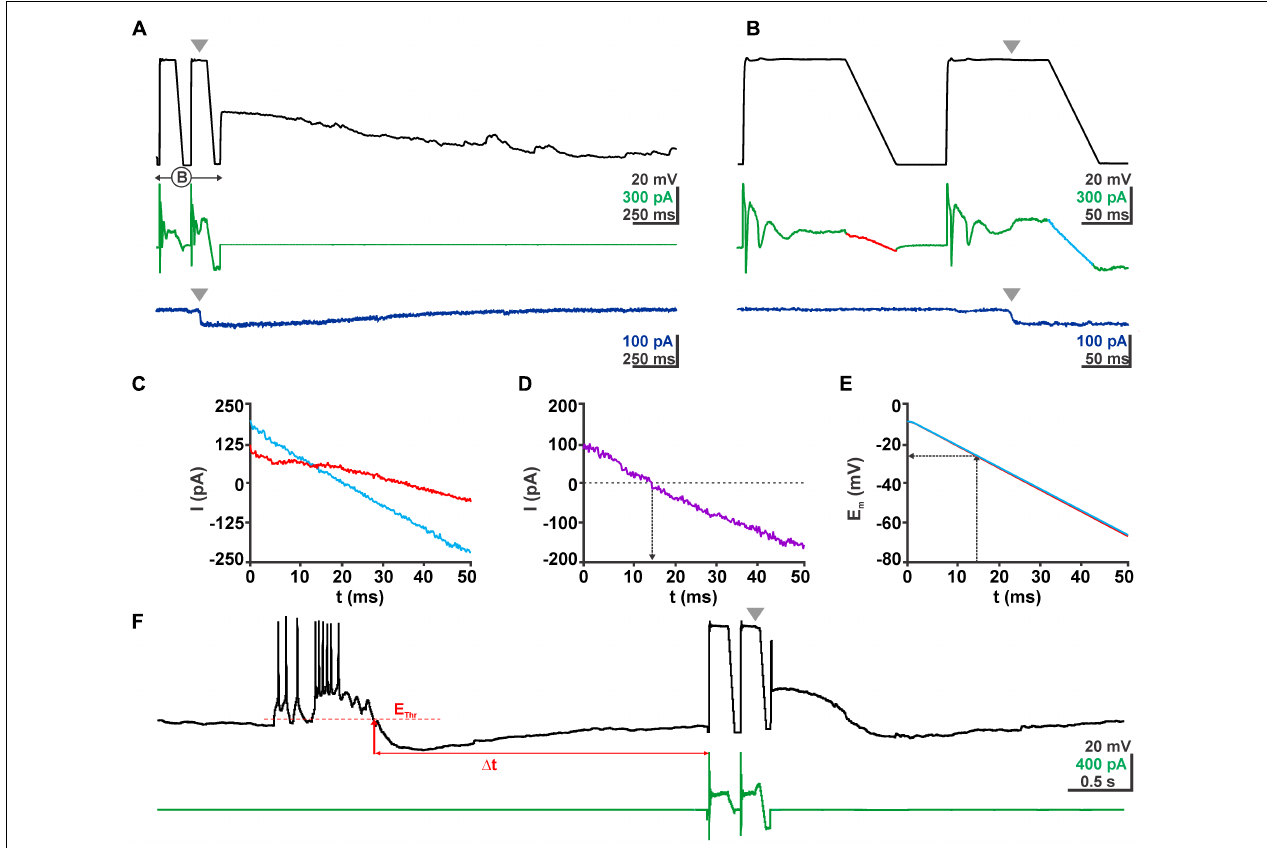
FIGURE 3 | Determination of E GABA using a voltage ramp protocol. (A) Voltage (black trace) and current (green trace) traces of a typical clamp protocol used to determine E GABA . Voltage ramps between –3 and –63 mV were given from a 100 ms long depolarizing phase to inactivate fast Na + currents. The second voltage ramp was delivered during the quasi-stationary phase of GABAergic response evoked by a short application of 100 µ M GABA pulse (gray arrowhead). The dark blue trace in the bottom depicts the current response of the same cell without a voltage ramp protocol to illustrate the stationarity of the GABAergic current during the voltage ramp. (B) The ramp interval as shown in (A) at a higher temporal resolution. (C) Current traces from (B) recorded in the absence (red) and presence (blue) of GABA. (D) The difference between both current traces reverses at 13 ms. (E) Voltage traces recorded in the absence (red) and presence (blue) of GABA. Note that both traces are virtually identical. From these traces the reversal potential was determined. (F) Voltage and current traces of an experiment illustrating the procedures of a GDP triggered ramp protocol. From a continuous recording in current-clamp mode the microcontroller identified a GDP that crossed the threshold (E Thr ), the end of this GDP was determined as the time point when E m recovers to E Thr . After a defined latency ( (cid:49) t) the microcontroller provided a pulse to the amplifier to switch to VC mode and run the ramp